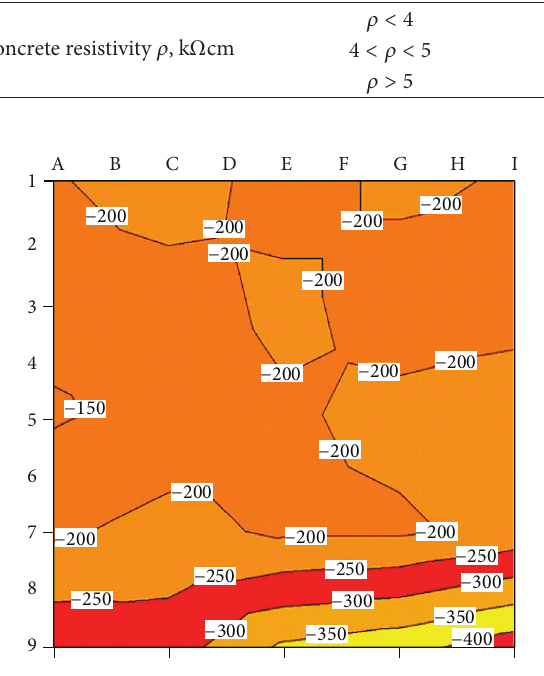
Figure 6: Contour plot of potential 𝐸 . Figure 7: Contour plot of concrete resistivity 𝜌 corr